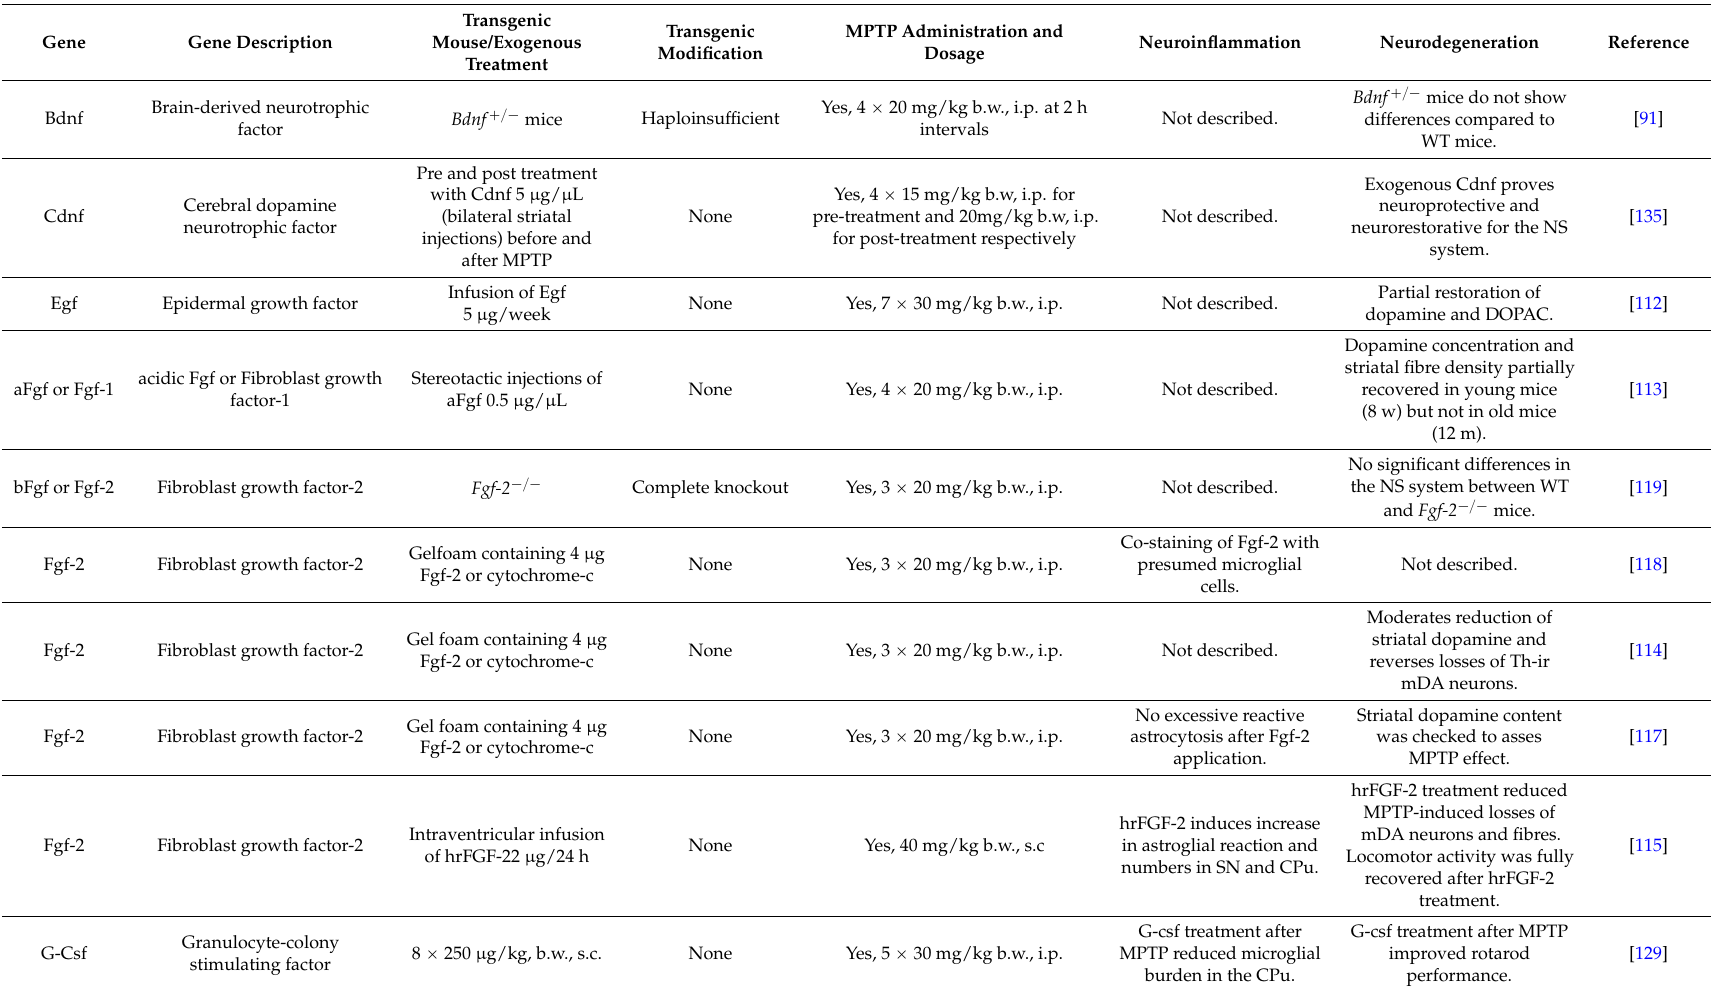
Table 2. Growth factors and neurotrophic